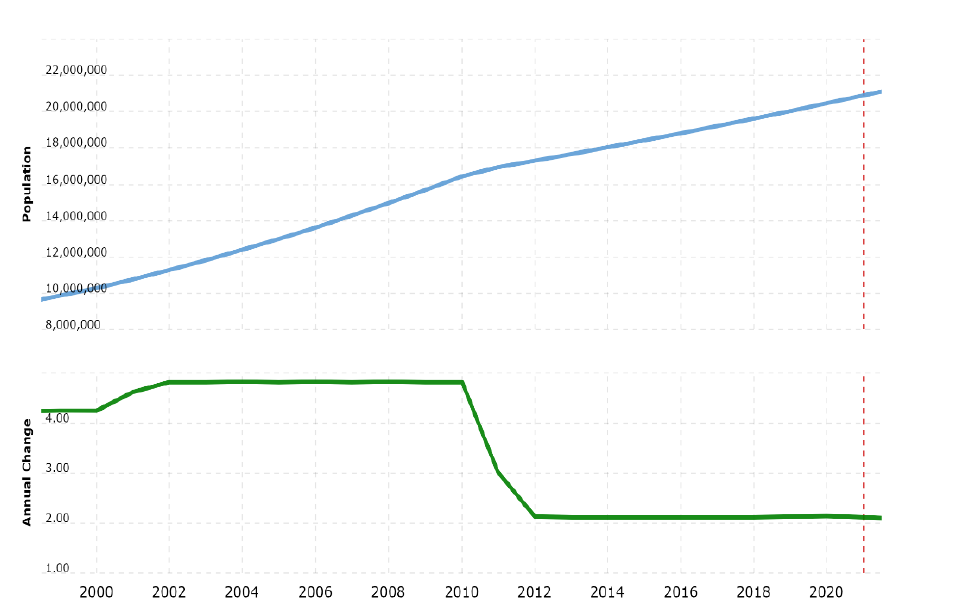
Fig. 2 Population division in Beijing from 1999 to